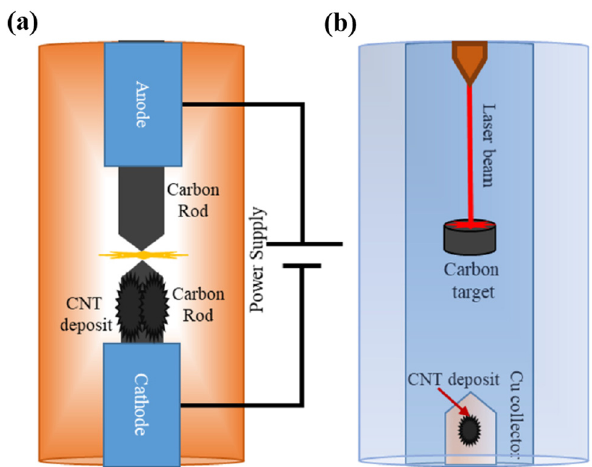
Figure 2: Schematic of ( a ) arc discharge method and ( b )